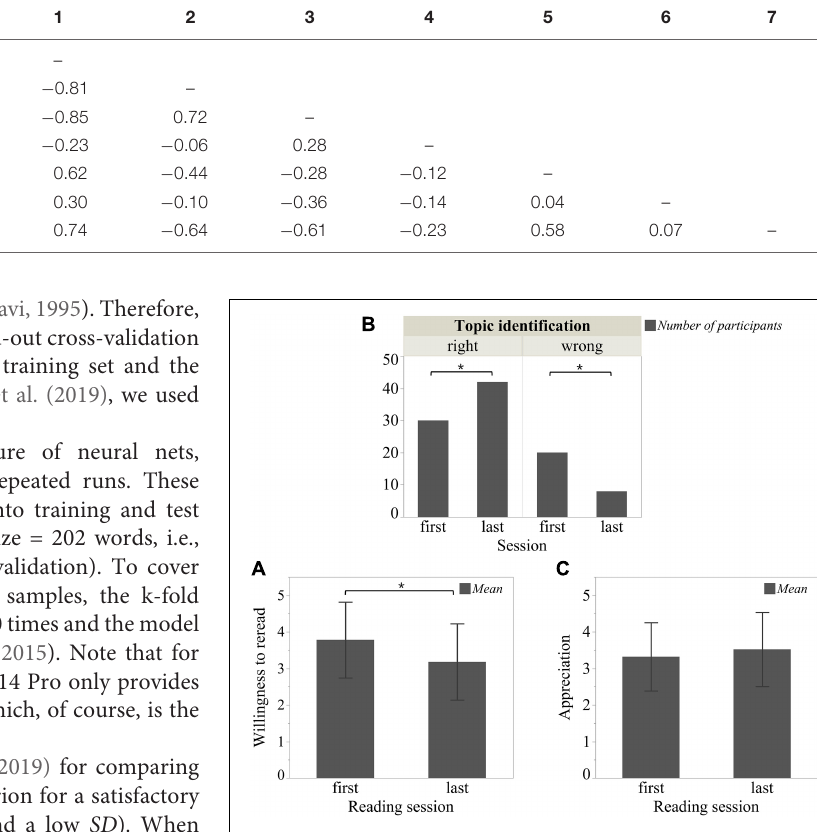
FIGURE 2 | Rereading effect on rating data. (A) “Willingness to do any rereading,” (B) “Topic identification,” and (C) “Appreciation” were separately collected from three questions: “I would like to read this poem again,” “Which is the main topic of this poem,” and “I like this poem.” For questions related to “Willingness to do any rereading” and “Appreciation,” readers indicated their agreement with the statements on a 5-point rating scale ranging from 1 = totally disagree to 5 = totally agree. For the topic identification question, six choices were offered, but only one was right. If readers agreed with none of the choices, they could put forward another, which was later evaluated by two experts from the humanities. * p < 0.05. Error bar is constructed using one standard deviation from the